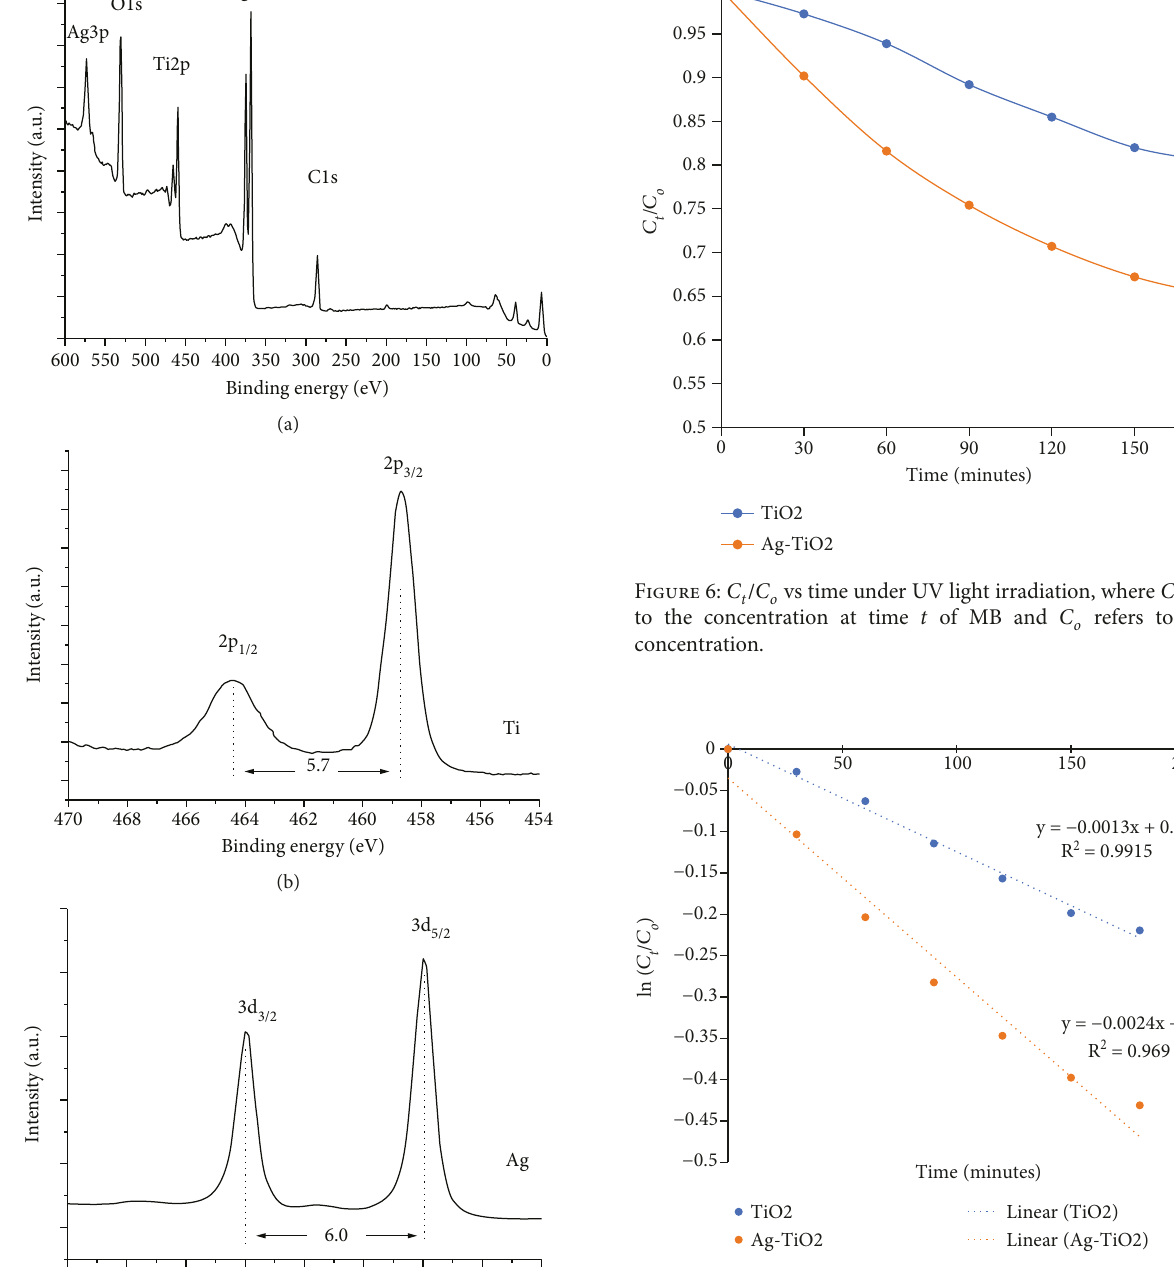
/ C t for tests, where C Figure 7: Fitting ln C t o vs t refers to the concentration of MB at time t and C o refers to the initial concentration of MB; inside fi gure is the R value and equation of linear fi Figure 5: (a) XPS spectrum to Ag-TiO thin fi lms, (b) HRXPS Ti 2p 2 spectrum to Ag-TiO thin fi lms, and (c) HRXPS Ag 3d spectrum to 2 Ag-TiO thin fi lms. All binding energies of the XPS spectra are 2 calibrated with reference to the C1s peak at 285eV. Table 1: Partial concentration for elements of Ag-TiO thin fi lms. 2 Element Oxygen Titanium Silver Carbon 39.1